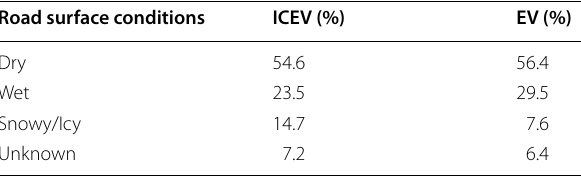
Table 2 Distributions of crashes by settlements